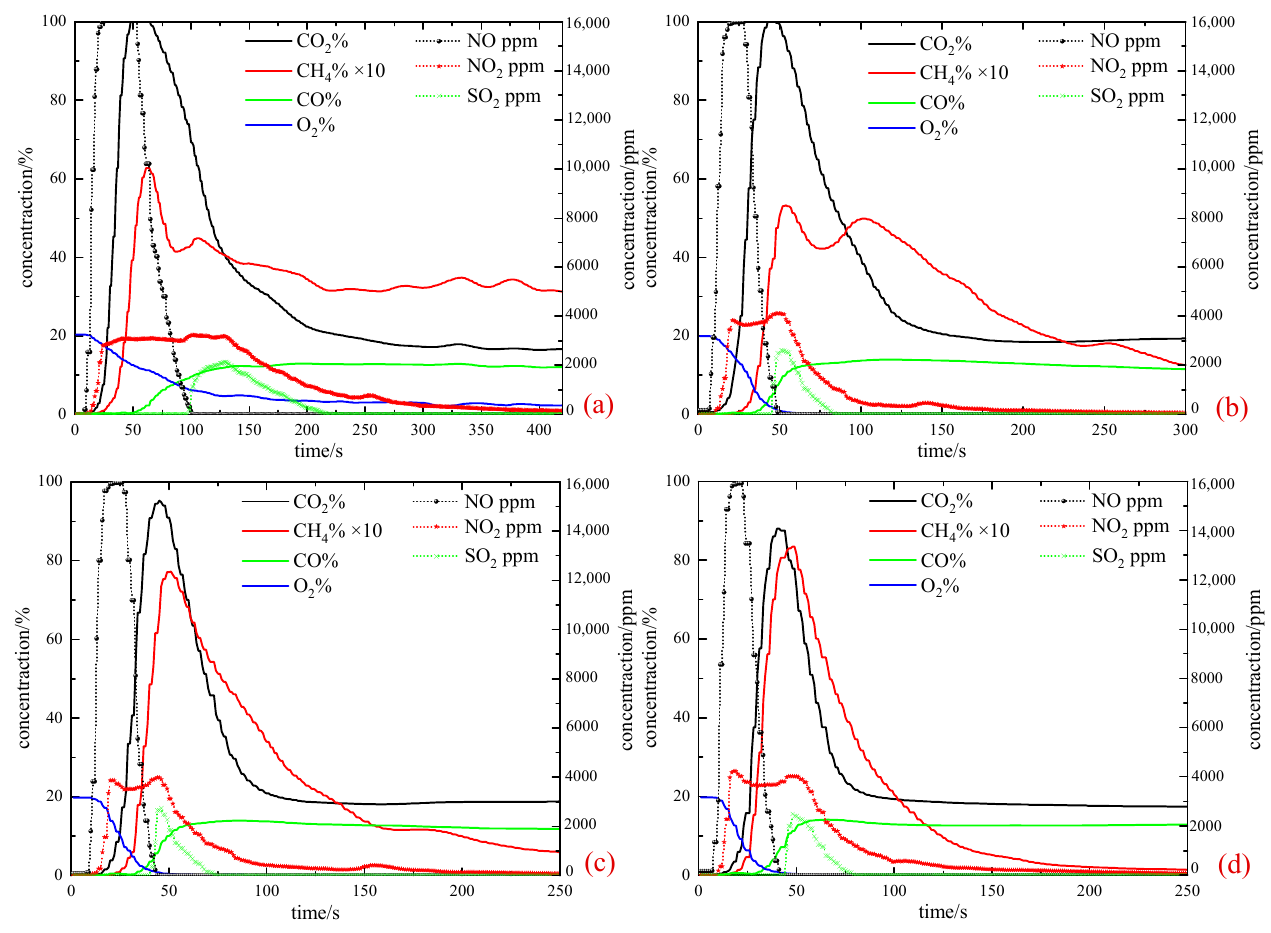
Figure 5. Flue gas analysis curves of the catalytic ignition process in a model thruster without the convergent nozzle at each flow rate: ( a ) 1 mL/min; ( b ) 2 mL/min; ( c ) 3 mL/min; ( d ) 4